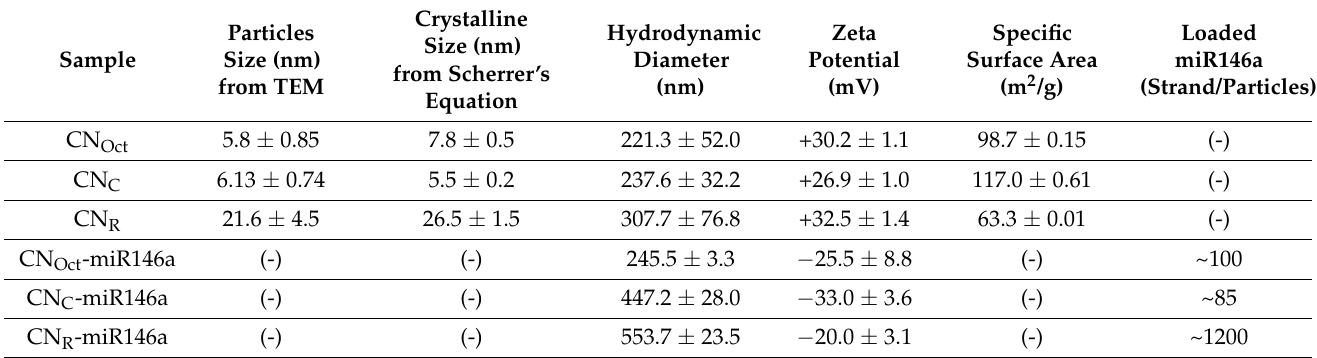
Figure 2. XRD and XPS of different shapes of CNPs were synthesized by the hydrothermal method. ( a ) shows the XRD patterns of CNPs-rod (bottom), CNPs-cube (middle), and CNPs-octahedra (top). The major peaks in the XRD for these nanoparticles correspond to the cubic structure of cerium oxide (ICSD: 98-018-9055) and the minor peak in the CNPs-rod XRD pattern corresponds to CePO 4 (ICSD: 98-018-2582). This result suggested that the CeO 2 structure has formed all conditions. Only, the CN R synthesis condition produces the CeO 2 along with traces of the CePO 4 phases. ( b – d ) shows the deconvoluted Ce3d binding region in the XPS spectrum of CN Oct , CN C , and CN R , and ( d )-insert shows the deconvoluted P2p region in CN R samples. The deconvoluted peaks are clearly distinguished according to their oxidation states of Ce 3+ (shown in red color) and Ce 4+ (shown in orange color) in the CeO 2 structure. Spectrum representatives for each sample are unique from each other: highlighting the distinct surface character of each morphology (e.g., faceting and vacancy site presentation). The percent of reduced cerium sites, relative to total cerium sites, was observed to increase with increasing material aspect ratio (26.8, 16.1, and 66.6% for CN Oct , CN C , and CN R , respectively). Table 1. The physicochemical properties (particle size, zeta potential, and specific surface area) of pure and conjugated samples and the loading number of miR146a calculated based miR concentration measured by Quant_iT_microRNA_Assay and CNPs concentration measured by